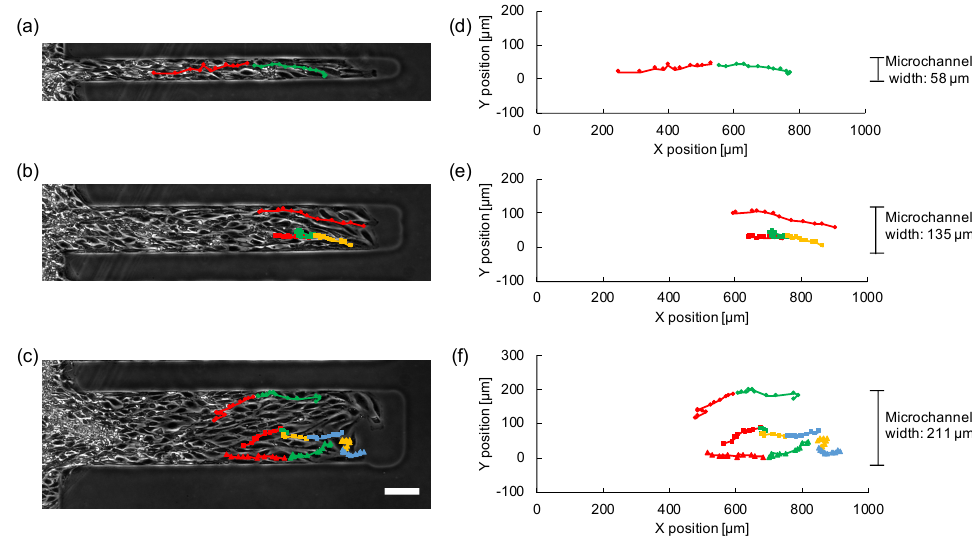
Figure 7. Tracking of single cells inside collective migration in wider microchannels. ( a – c ) Micro- graphs of collective cell migration with superimposed single cell tracking in wider microchannels having 58µm ( a ), 135µm ( b ), and 211µm ( c ) widths. Each plot shows the position of the cell trac- ing in 1 h interval and lines connecting those plots to indicate the tracking of single cells in the microchambers. The colors of plots and lines of each tracking was changed every 12 plots from red, green, yellow, to blue, respectively, to emphasize the temporal aspect of these tracking intervals. ( d – f ) Graphs of those plots and tracking lines of ( a – c ), respectively. X-direction represents the direc- tion of microchannel length, and Y-direction represents the direction perpendicular to the direction of microchannel length or the direction of microchannel width. Bar: 100µm.